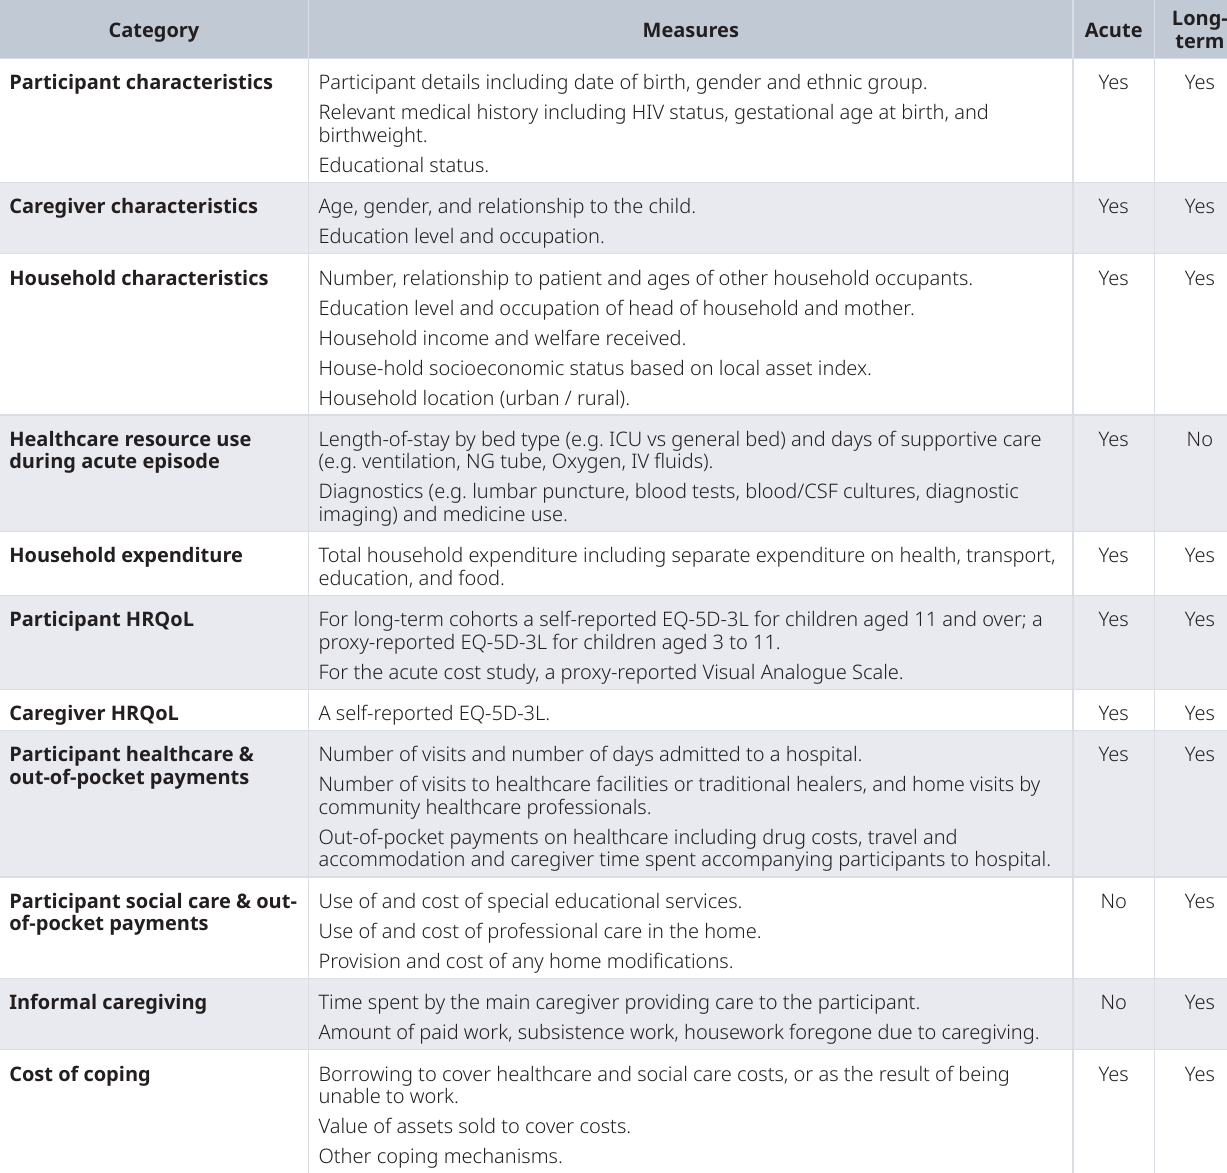
Table 5. Economic data to be collected as part of the long-term and acute cost studies.